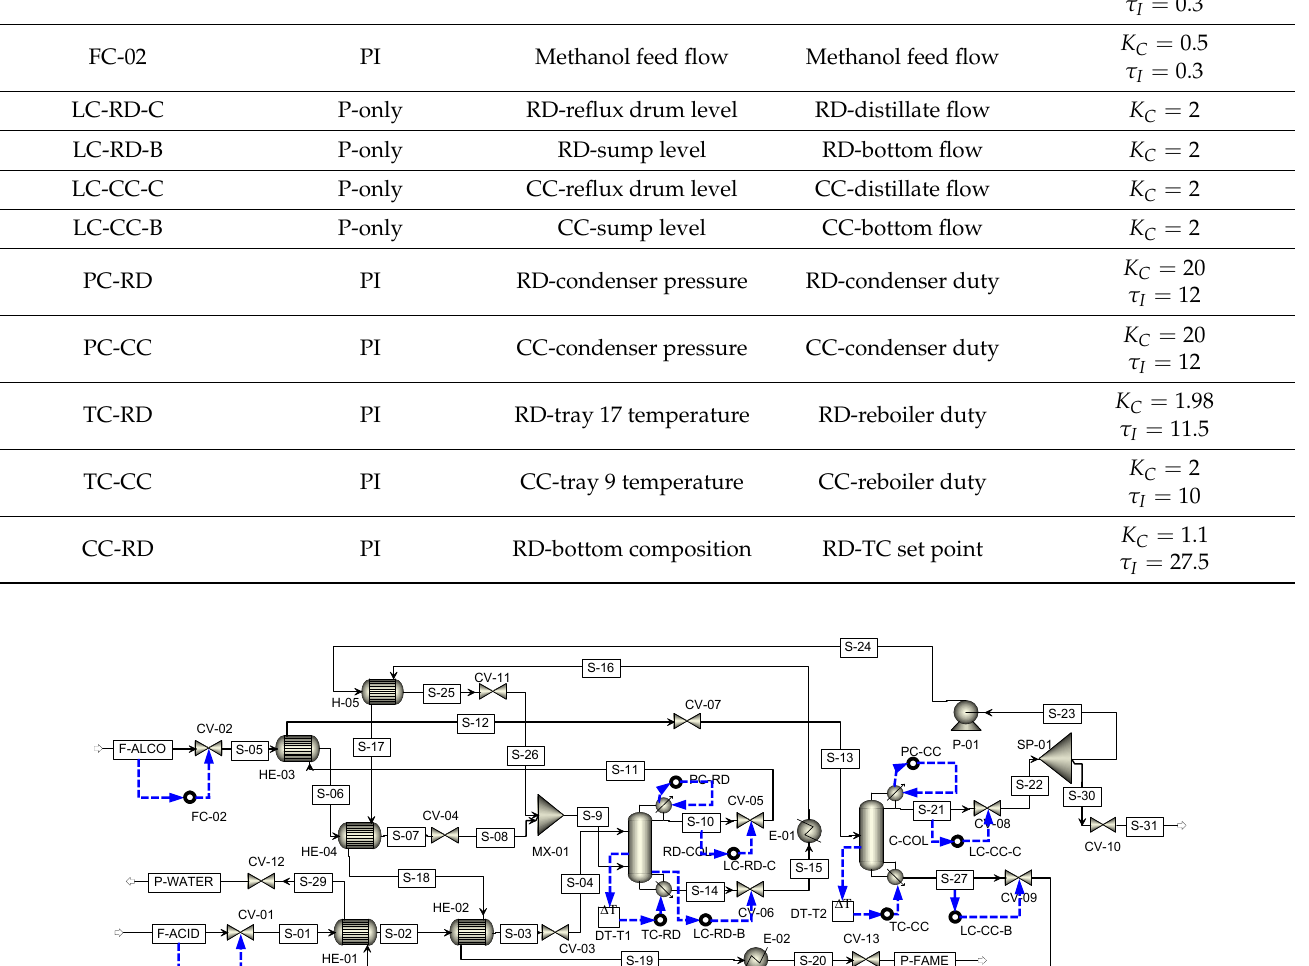
Figure 8. Control scheme faceplates of the process.